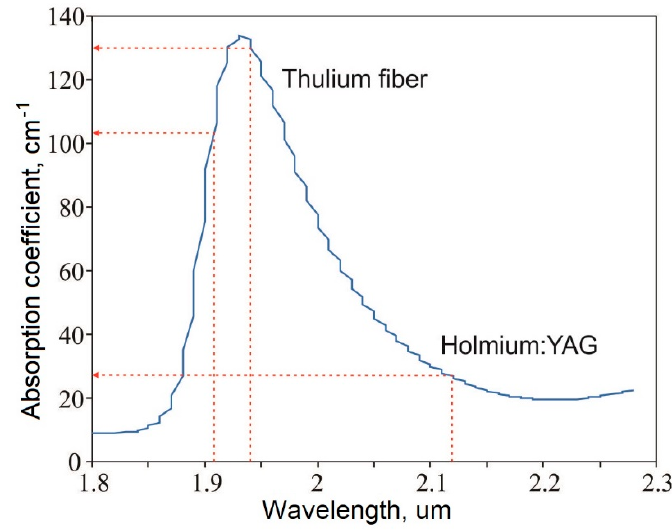
Figure 1. Dependence of the absorption coefficient of water (22 °C) on the wavelength of radiation in the area of the local peak ≈ 2 µm [14].